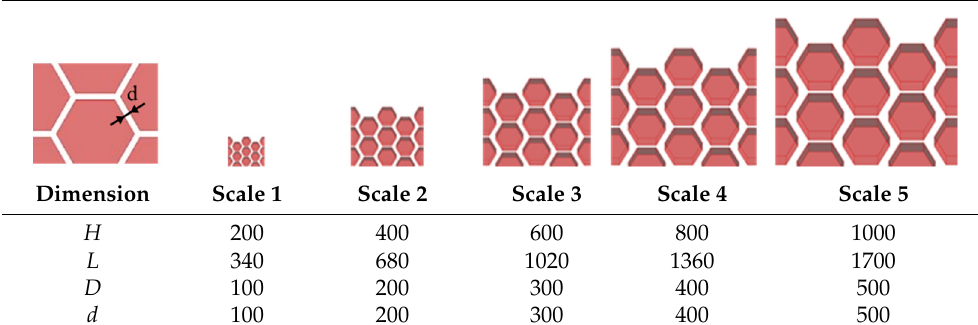
Table 3. Baseline dimensions and scaling of the closed-type structures analysed in this work; units in µm.